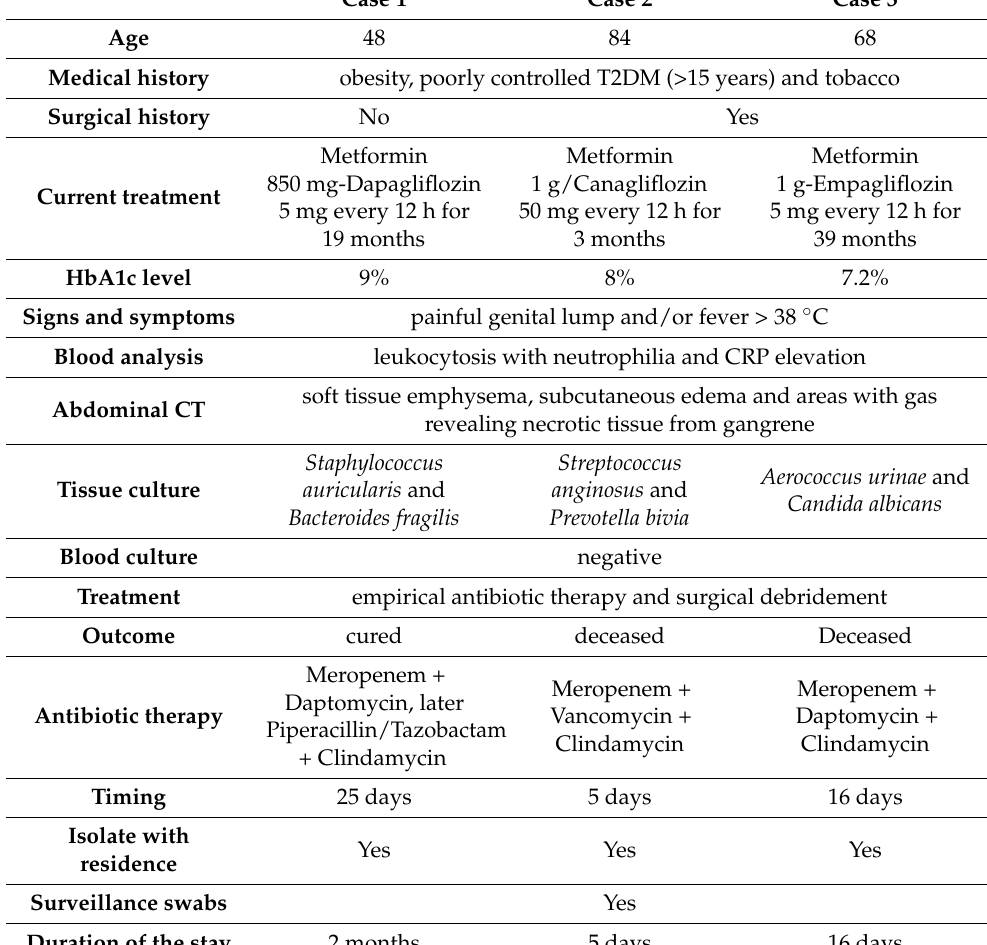
Table 1. Comparison table. Representation of the three cases and their main